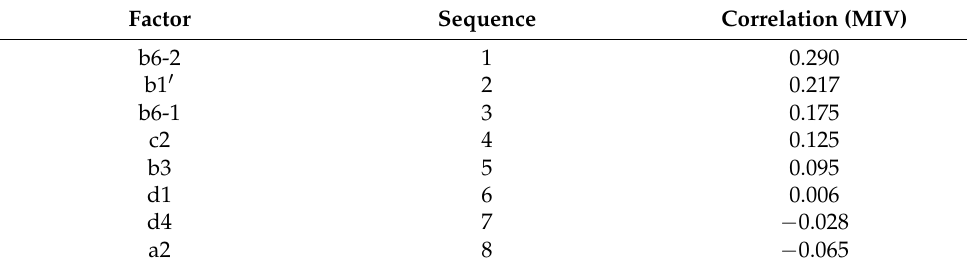
Table 3. Results of filtering by MIV method.